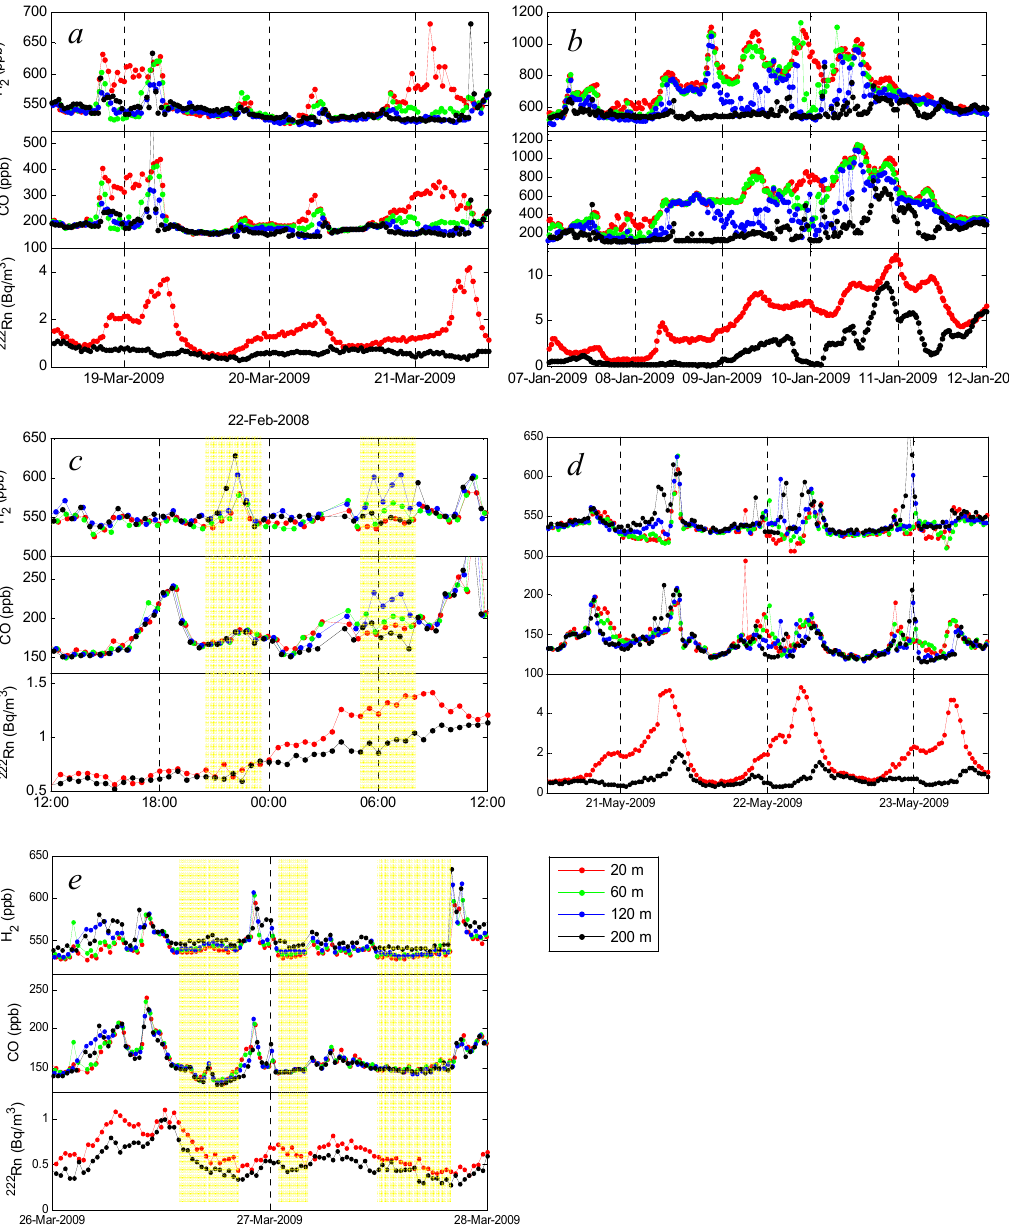
Fig. 5. Examples of H 2 and CO signals. (a) Evening and morning peaks during rush hours, and night time accumulation. (b) Large scale pollution event. (c) Pollution events detected at the highest sampling altitude (highlighted). (d) H 2 data from 20 and 60m show night time depletion due to uptake by soil, while 222 Rn, continuously emitted by soil, is accumulating in the stable boundary layer. (e) Reversed H 2 gradient